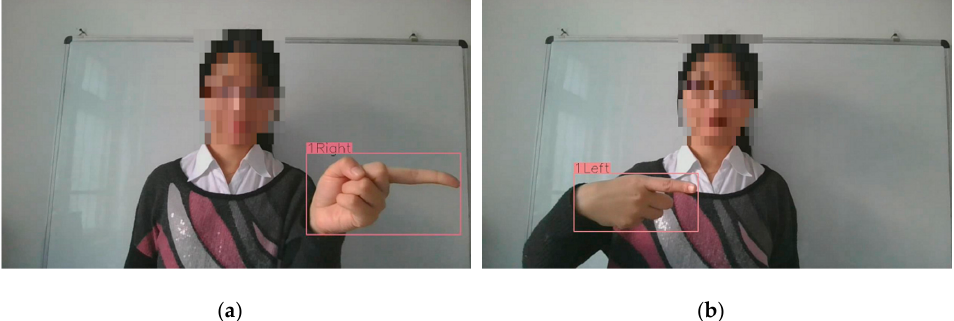
fails. ( a ) The hand posture is incorrectly classified; ( b ) the hand posture is correctly classified. Figure 28. Example of comparison when the system correctly classifies the hand posture and when it